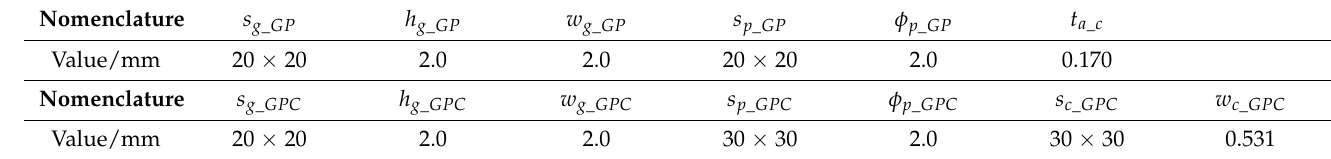
Figure 2. Core machining configurations: ( a ) plain core, ( b ) GP core, and ( c ) GPC core. Table 1. The dimensions of the groove, perforated hole, contour cut, and their spacings.